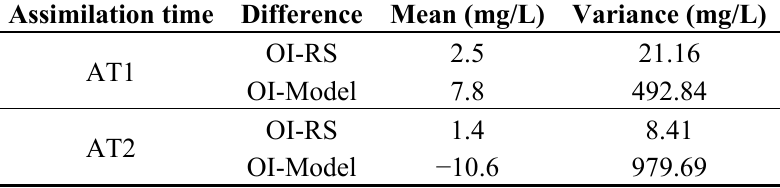
Table 3. The mean value and variance of the spatial difference between OI results and model results and the spatial difference between OI results and remote sensing sediment at the two assimilation